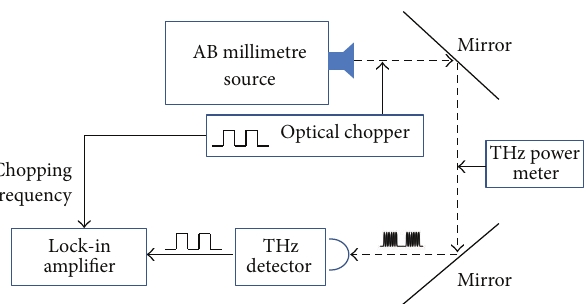
Figure 12: Photographs of the fabricated antenna.